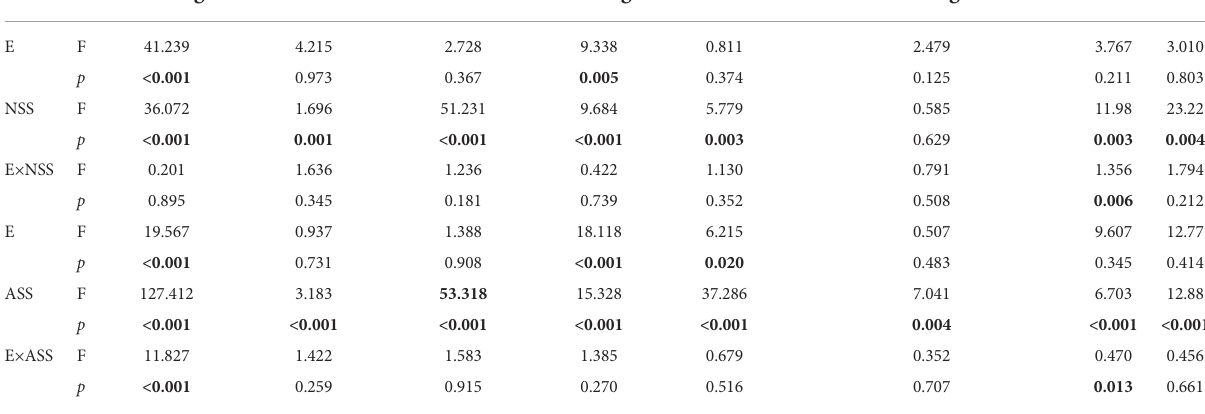
TABLE 1 ANOVA results for the effect of endophyte status, salt stress on vegetative growth of L. chinensis . Plant height Tiller number Leaf number Leaf length Leaf width Ratio of leaf length to width